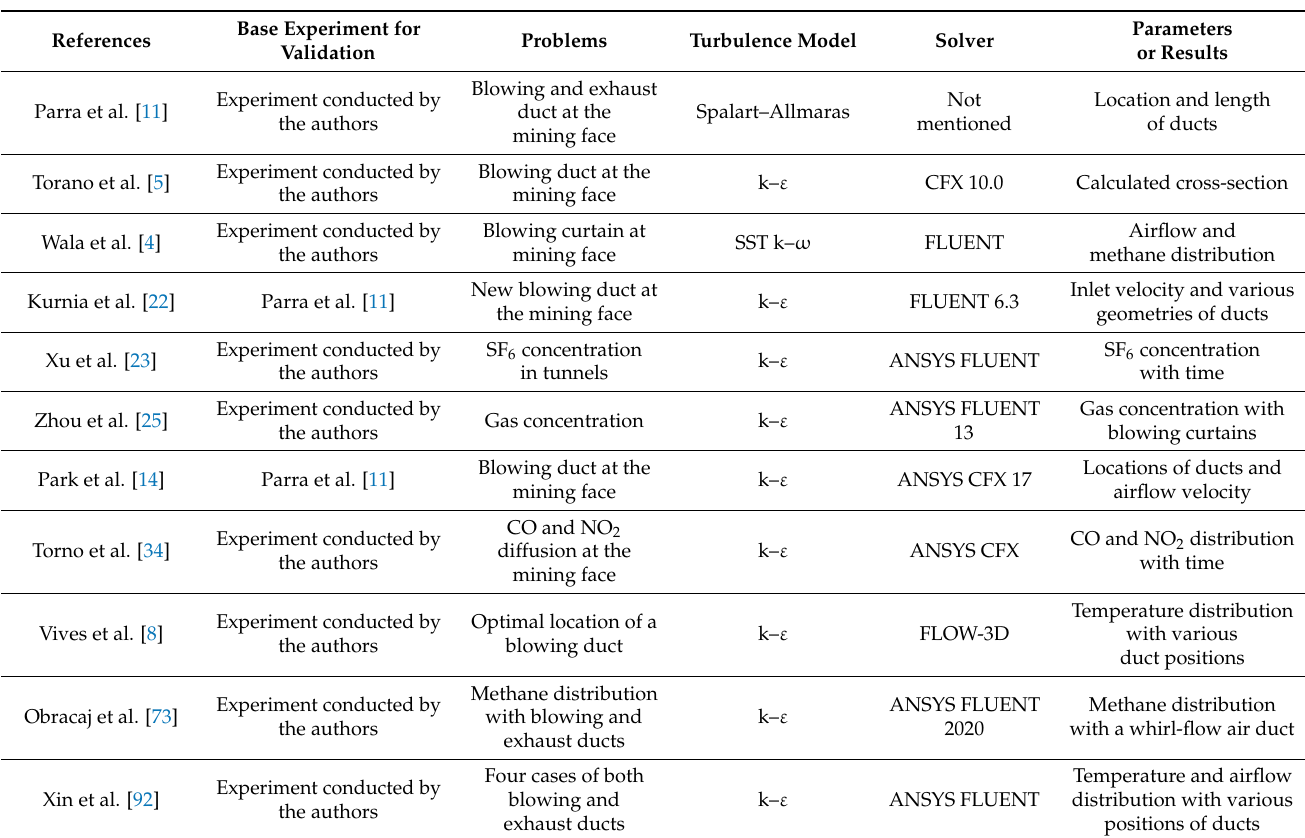
Table 1. Comparison between CFD applications in mine ventilation